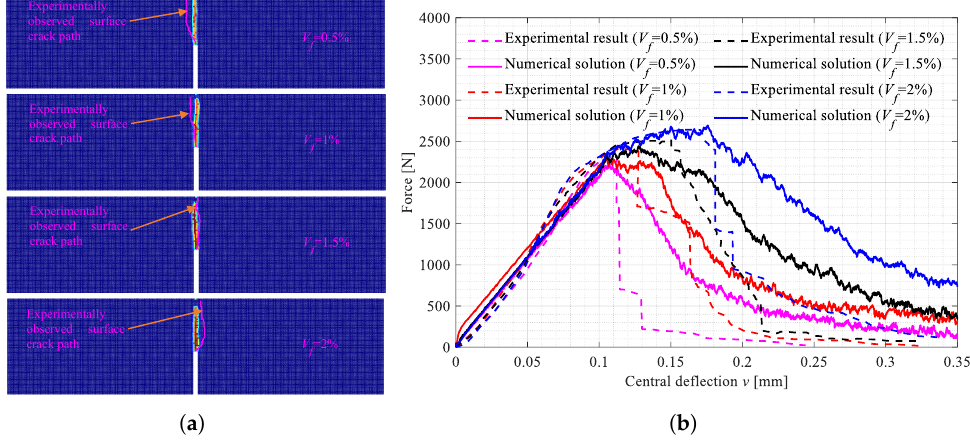
Figure 12. The crack patterns in the beam specimens with C l = 0 mm and the central deflection-force diagrams. ( a ) Surface crack patterns; ( b ) Central deflection-force diagrams.